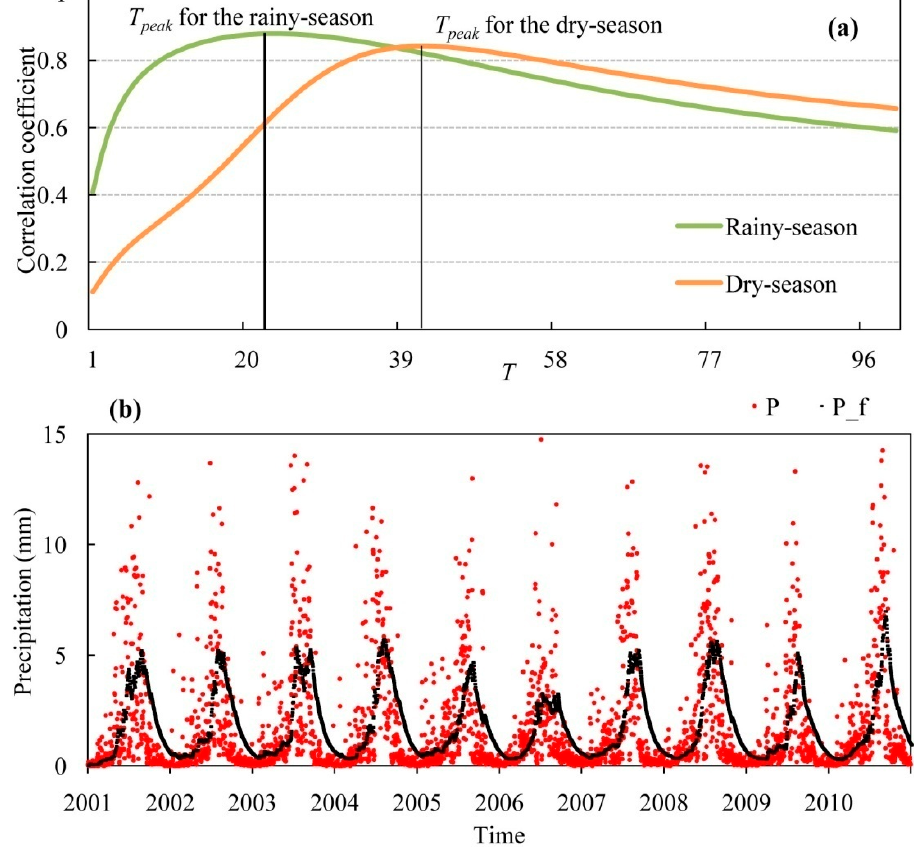
Figure 5. Variations in correlation coefficient for daily precipitation and discharge with varying T at Nuxia station basin ( a ), as well as the original and filtered TRMM precipitation average (P, P_f) over Nuxia basin ( b ) during 2001–2010.